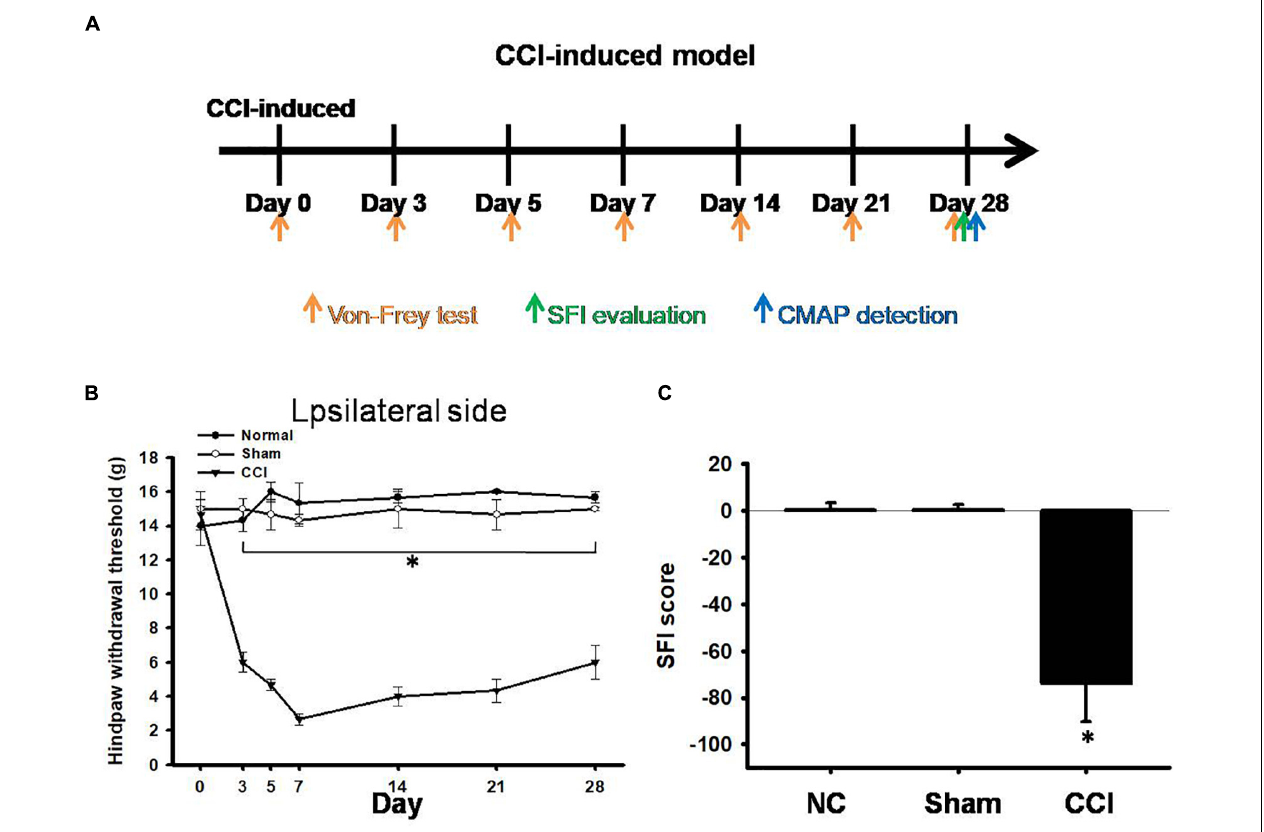
FIGURE 1 | Pain hypersensitivity in chronic constriction injury (CCI) rats. (A) Schematic view of the establishment of neuropathic pain animal model. (B) Thresholds for hindpaw withdrawal responses to Von Frey filament stimulation on the ipsilateral site in the normal, sham, and CCI groups, two-way ANOVA with Bonferroni post hoc test. (C) Determination of the sciatic functional index (SFI) in the normal, sham, and CCI groups, the data was analyzed by one-way ANOVA with post hoc Dunnett’s test. ∗ p < 0.001 was considered significant as compared with the CCI group, n = 8.